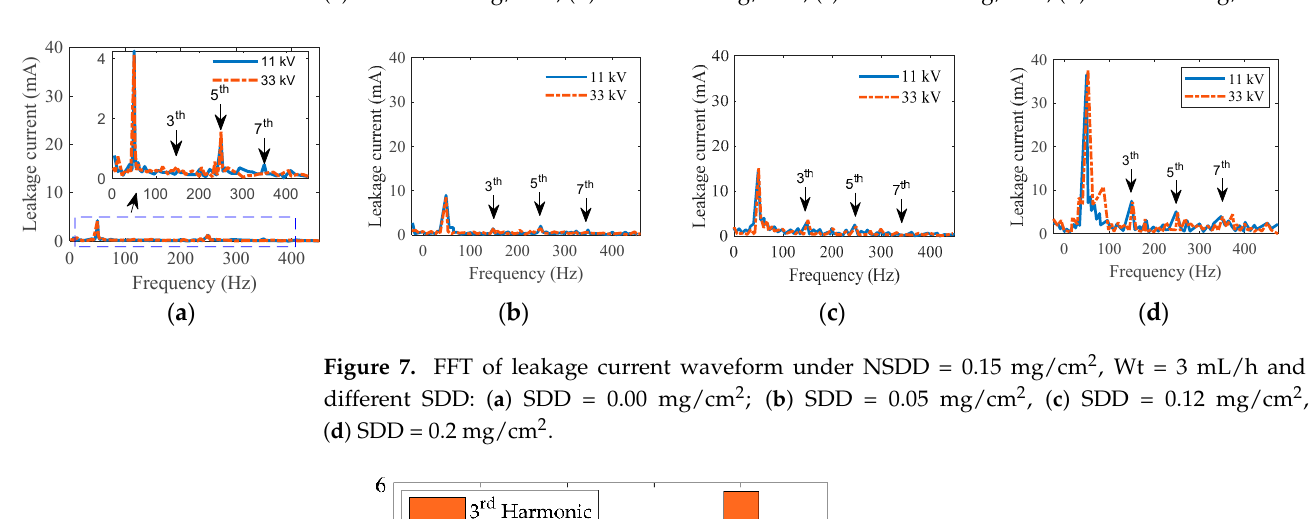
Figure 6. Leakage current waveform under NSDD = 0.15 mg/cm 2 , wt = 3 mL/h and different SDD: ( a ) SDD = 0.00 mg/cm 2 ; ( b ) SDD = 0.05 mg/cm 2 , ( c ) SDD = 0.12 mg/cm 2 , ( d ) SDD = 0.2 mg/cm 2 .